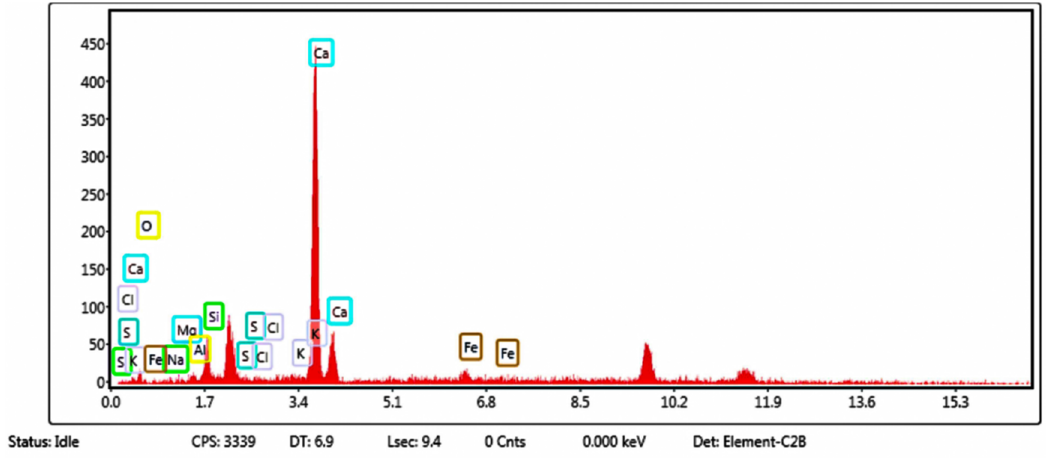
Figure 14. EDS, concrete specimen containing type II bacteria.